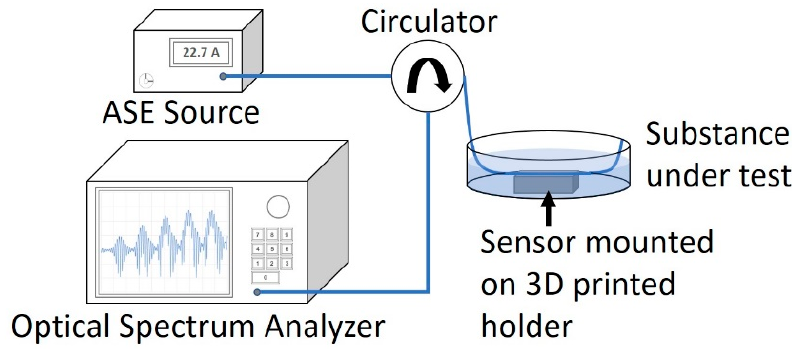
Figure 7. Experimental setup.